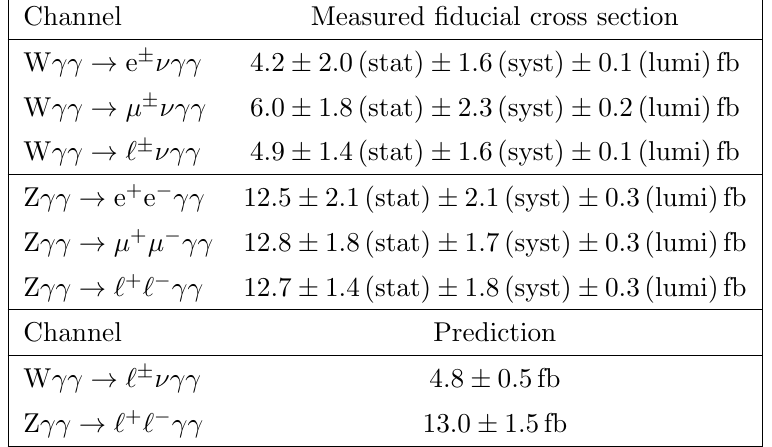
Table 4 . Measured (cid:12)ducial cross section for each channel and for the combination of channels for the W (cid:13)(cid:13) and Z (cid:13)(cid:13) analyses. The combined cross sections assume lepton universality and are given for the decay to a single lepton family ( ‘ ). The predictions are reported as